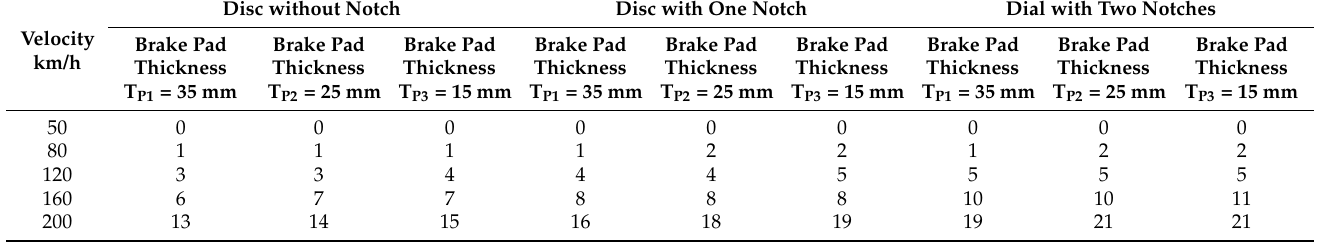
Disc with One Notch Dial with Two Notches